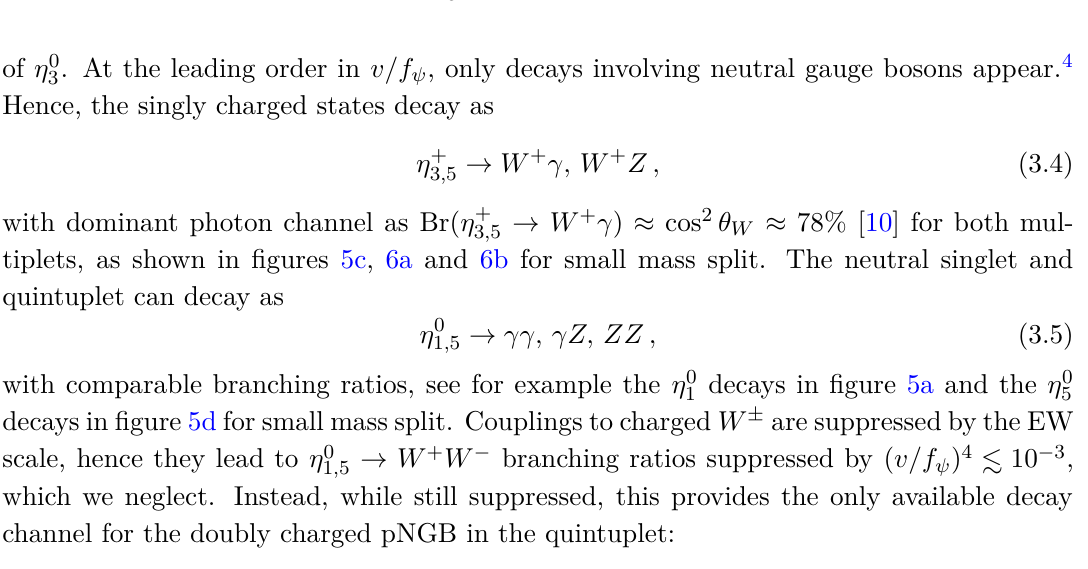
Figure 4. Example of Drell-Yan production of two pNGBs with cascade and anomaly decays. If the triplet is the lightest multiplet, the η 0 undergoes three-body decays via off-shell 3